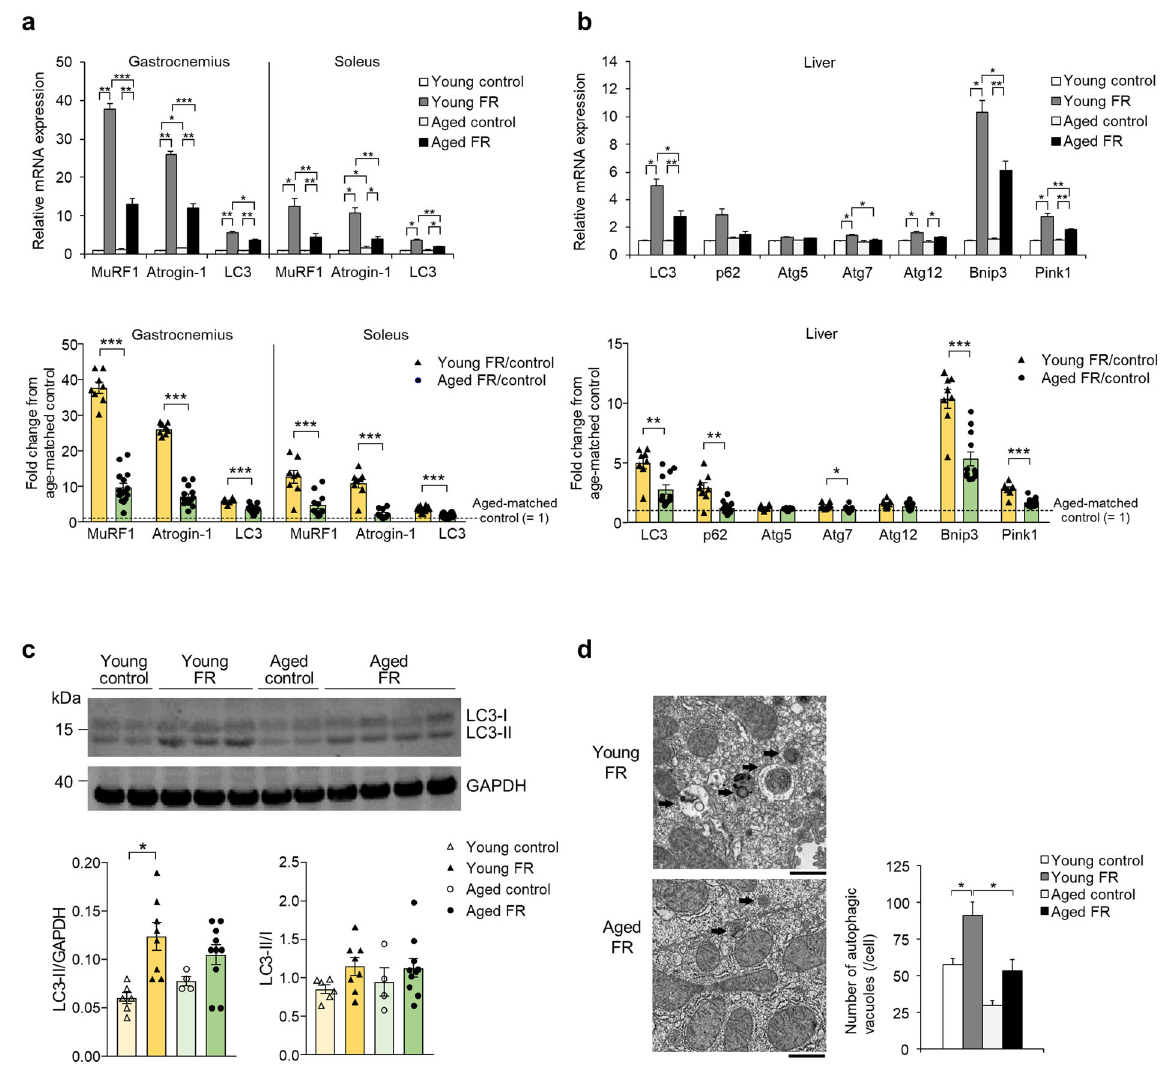
Fig. 5 Proteolysis and autophagy in muscle and liver on day 5 of food restriction. The gene expression in a muscle and b liver of young and aged food-restricted (FR) mice, * P < 0.05, ** P < 0.01, *** P < 0.001 by the Steel – Dwass test (upper panel) or Student ’ s or Aspin – Welch t test (lower panel). Gastrocnemius: young control ( n = 7), young FR ( n = 8), aged control ( n = 7), and aged FR ( n = 15). Soleus and liver: young control ( n = 6), young FR ( n = 8), aged control ( n = 5), and aged FR ( n = 12). c LC3-II protein expression levels and LC3-II/I ratio in the liver with representative western blot images. Blots were cropped to improve conciseness, and full-length blots are presented in Supplementary Fig. 5. * P < 0.05 by Steel – Dwass test: young control ( n = 6), young FR ( n = 8), aged control ( n = 4), and aged FR ( n = 10). d Electron microscopic images of hepatic autophagic vacuoles and the number per cell ( fi ve hepatocytes/mice, n = 3 mice/group). Bar = 1 μ m. Arrows indicate autophagic vacuoles, * P < 0.05 by Tukey − Kramer test. Data are presented as mean ±